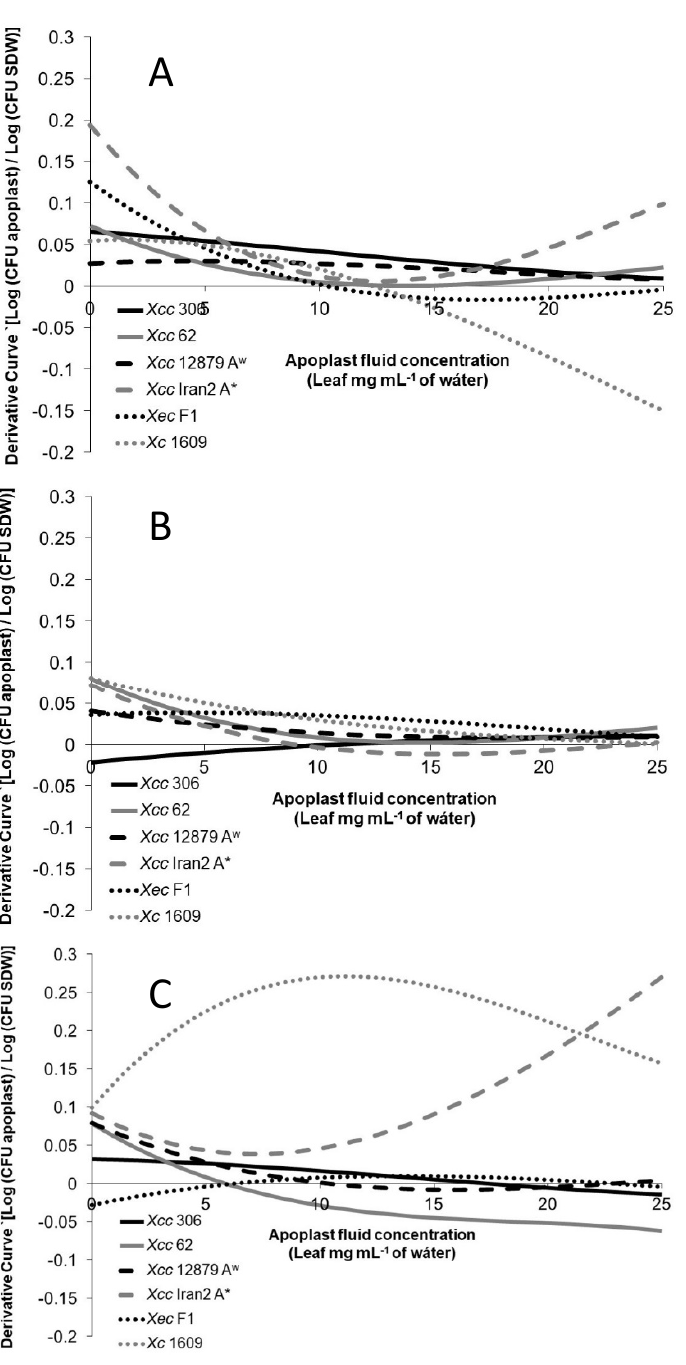
Figure 4. Variation of the chemotaxis response of Xanthomonas strains toward leaf apoplastic fluids at different concentrations (from 0 to 25 leaf mg mL − 1 ) from ( A ) sweet orange, ( B ) Mexican lime, and ( C ) Chinese cabbage. The graphs show the derivative curve of the regression curve obtained from data of the chemotaxis assay explained before. The chemotactic responses of the xanthomonads strains fitted onto polynomial regression curves (r 2 > 0.8) were derived and the curves plotted. Herein, apoplastic fluid concentrations from 0 to 25 mg mL −1 were selected because almost no variation ( P > 0.05) was observed at higher concentrations, due to a possible saturation of chemoreceptors.